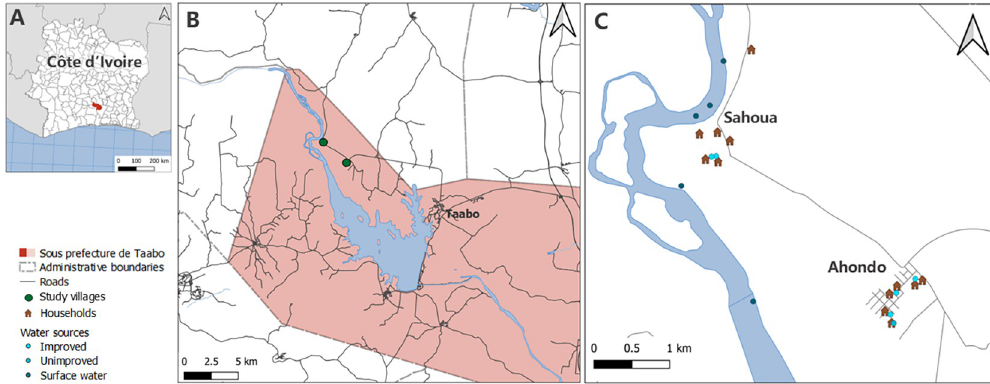
Fig 1. Map indicating the study area. (A) Coˆte d’Ivoire; (B) “sous-prefecture de Taabo”; and (C) the location of households and type of water sources of Buruli ulcer cases in the two study villages Ahondo and Sahoua. Base-layers retrieved